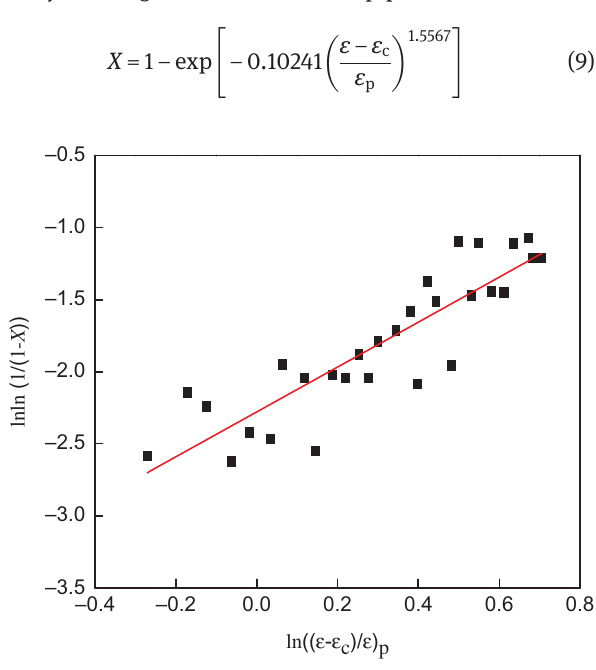
Figure 7: Relationship between lnln(1/(1 – X )) and ln(( ε - ε c )/ ε p ).